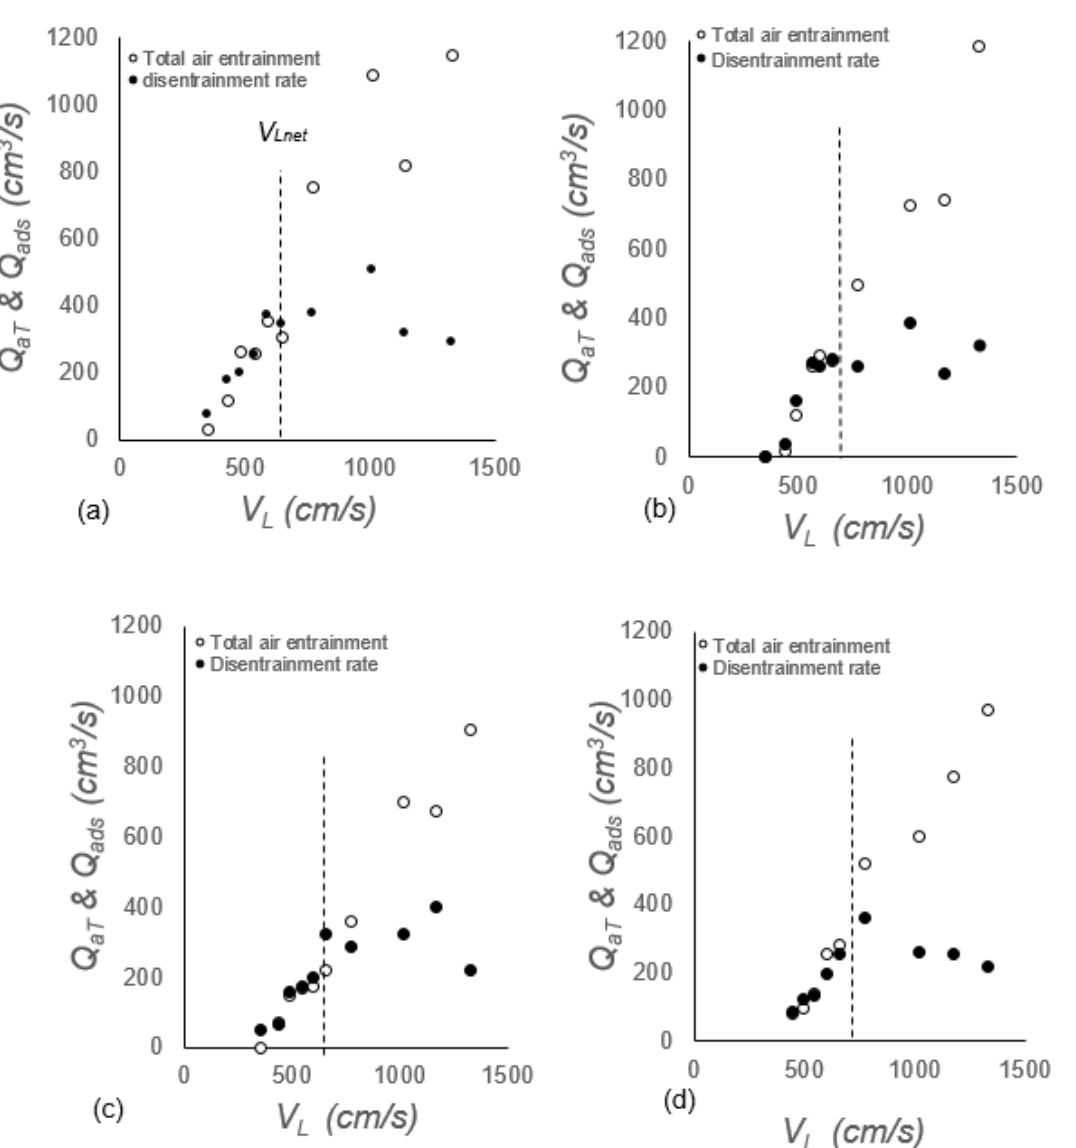
Figure 9. Total air entrainment and disentrainment flow rates for ( a ) d s = 0, L j = 43 cm, H c = 46 cm; ( b ) d s = 1, L j = 44 cm, H c = 45 cm; ( c ) d s = 3, L j = 46 cm, H c = 43 cm; and ( d ) d s = 5, L j = 48 cm, H c = 43 cm for downcomer with l ADR = 40 cm.